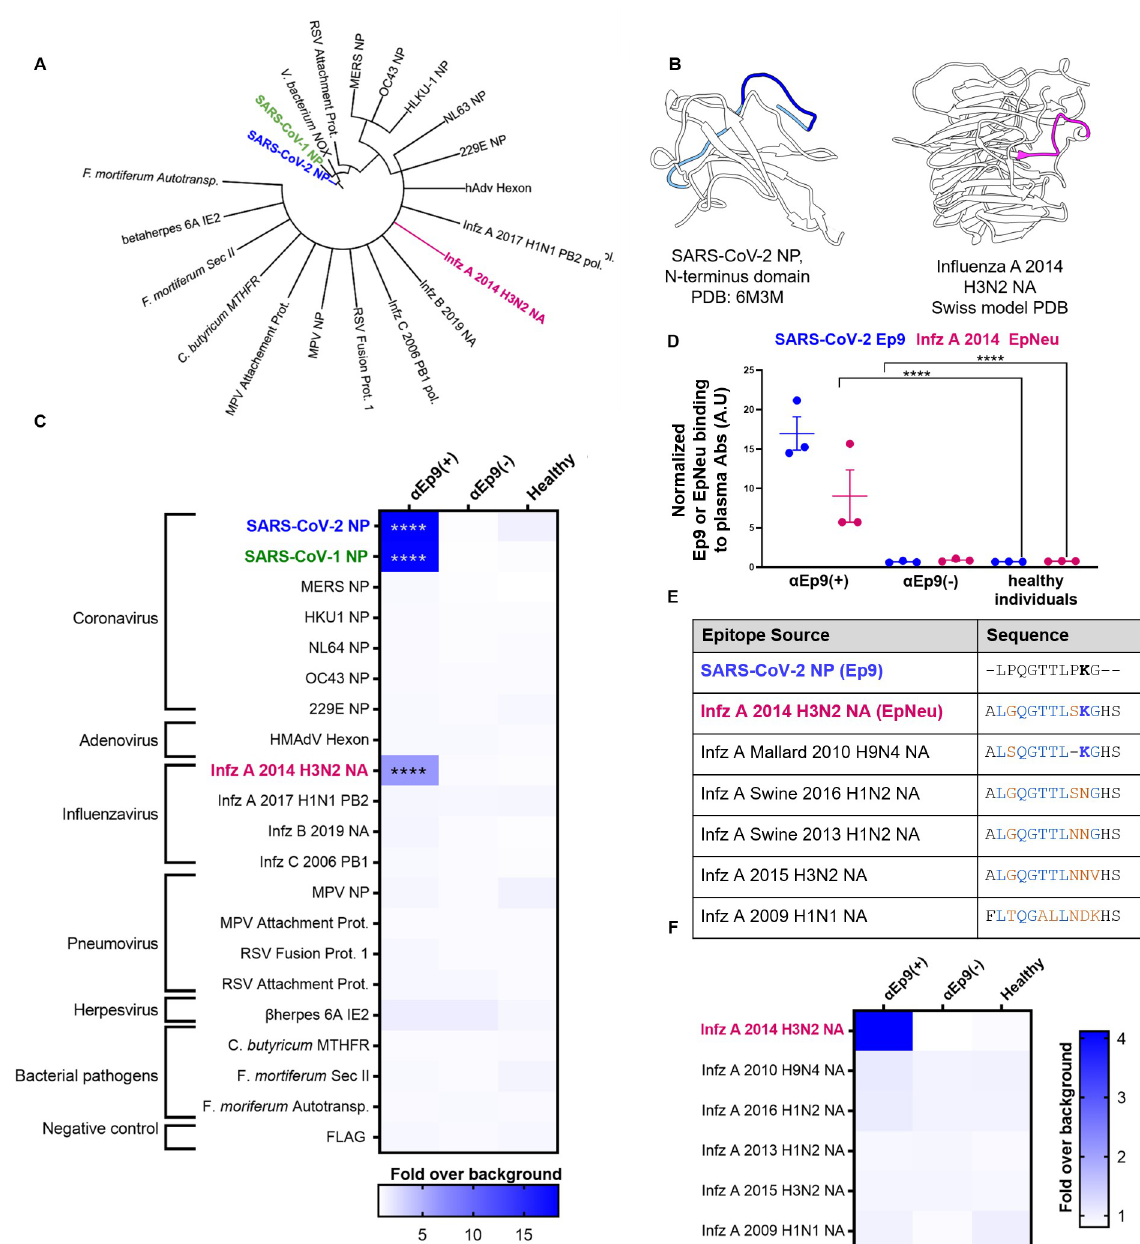
Fig 1. Potential OAS epitopes for binding α Ep9 Abs suggested by bioinformatics and tested by phage ELISA. ( A ) Cladogram depicting sequence homology of the Ep9 sequence from SARS-CoV-2 to the bioinformatics-identified, closest homologs. Sequence alignments used pBLAST and VAST, and the cladogram was generated by iTOL [13]. ( B ) Structures of SARS-CoV-2 NP RNA binding domain (PDB: 6M3M) and the influenza virus (Infz) A 2014 H3N2 NA protein (modeled by SWISS-Model [14]). SARS-CoV-2 NP highlights Ep9 residues (light and dark blue) and the region homologous region to EpNeu (dark blue). The depicted model of Infz A 2014 H3N2 NA highlights the EpNeu putative antigen (pink). ( C ) ELISAs examined binding of phage-displayed potential OAS epitopes to total Ig from three sets of pooled plasma from five α Ep9(+) patients, or five α Ep9( − ) patients. Pooled plasma from healthy individuals was an additional negative control. The colors of the heat map represent the mean binding signal normalized to phage background negative controls (signal from phage without a displayed peptide). ( D ) Expansion of data from panel C shows ELISA signals from the independently assayed individual pools shows results from the individual pools ( ���� p < 0.0001 for a two-way ANOVA comparing binding of phage-displayed epitopes listed in panel C to different groups of pooled plasma, ad hoc Tukey test). ( E ) Amino acid sequence alignment of the closely related Infz A NA homologs of EpNeu from pBLAST [11]. Blue and orange residues represent conserved and mismatched amino acids, respectively, relative to Ep9. Bolded residues are important for epitope recognition by α Ep9 Abs. ( F ) Using EpNeu as the search template to generate homologous sequences (shown in panel E), ELISAs